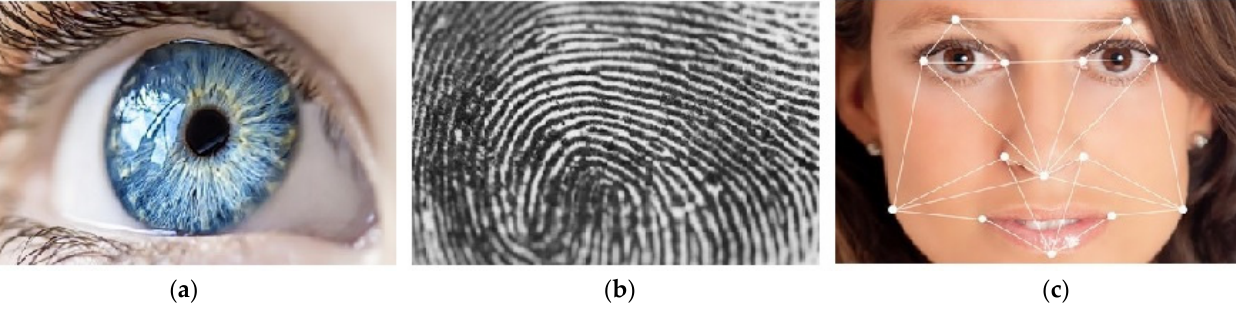
Figure 1. Diversity and accuracy of biometrics systems: ( a ) iris texture—high diversity and accuracy; ( b ) fingerprint pattern—middle diversity and accuracy; ( c ) face image—low diversity and accuracy.